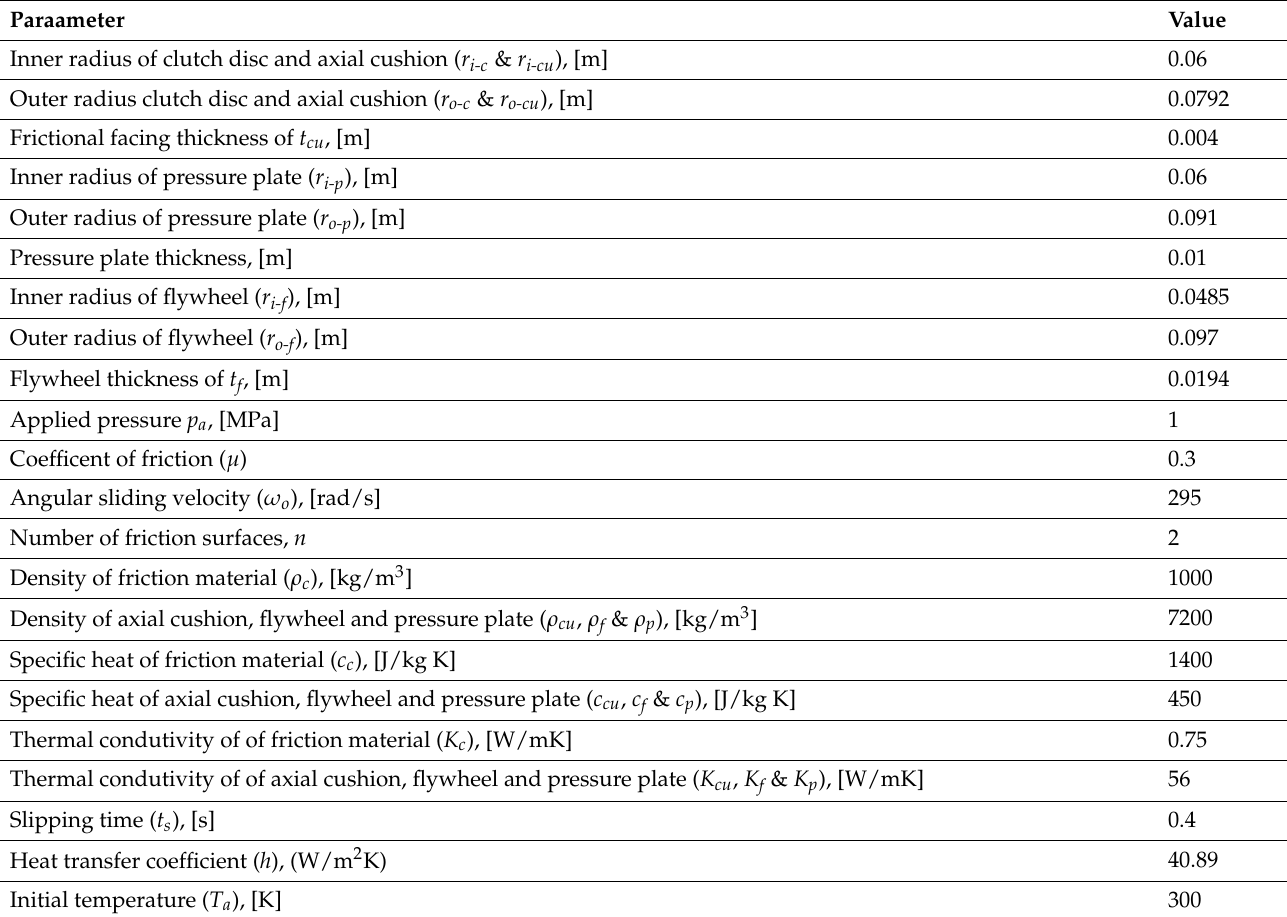
Table 1. The material properties and working parameters of clutch system